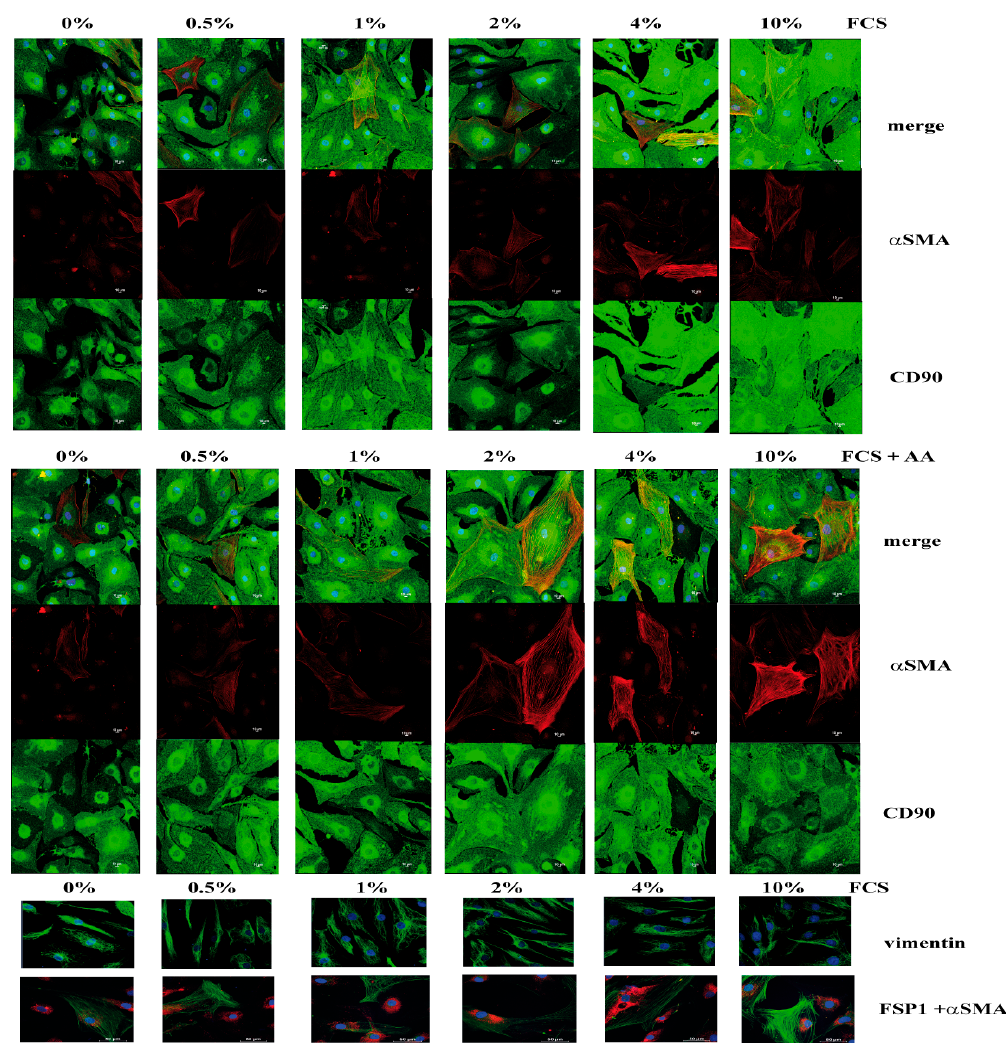
Figure 3. Expression levels of CD90 (green), FSP1 (red), vimentin (green) and α SMA (green) in